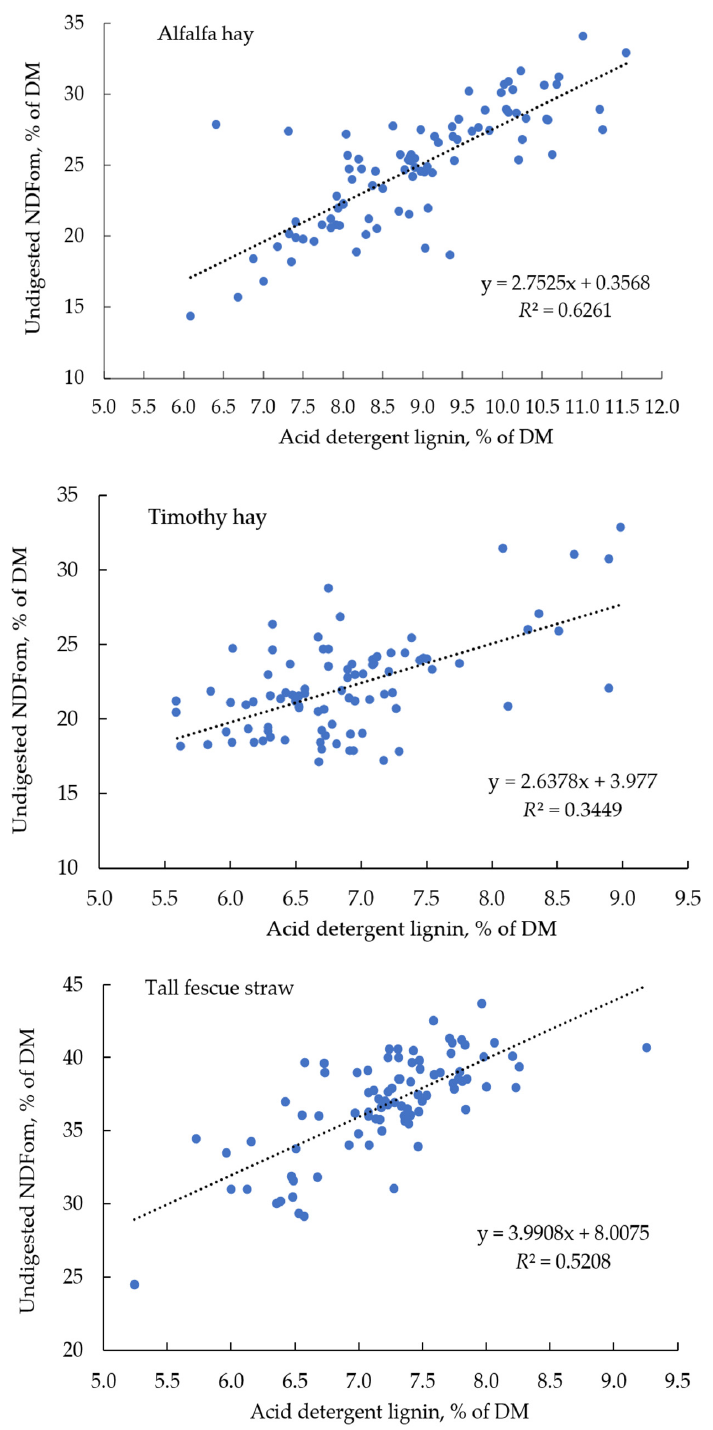
Figure 1. Undigested NDFom regressed on acid detergent lignin, as classified by forage type (experiment 2).